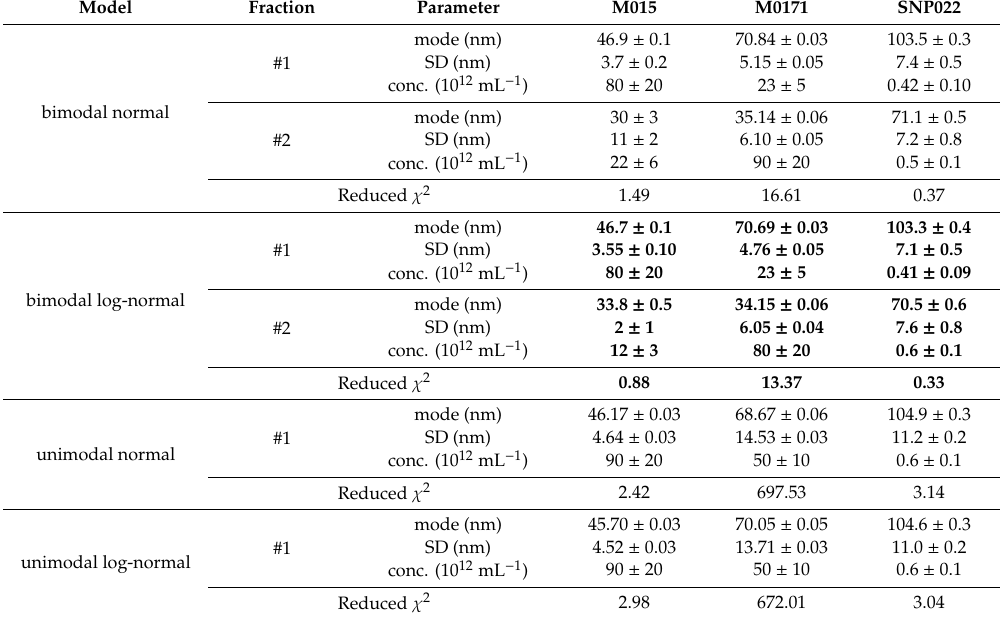
Table 2. Mode and scatter parameters as well as concentrations of the size fractions of the nanoparticle systems determined by SAXS assuming uni- and bimodal normal and log-normal size distributions. Values corresponding to the best fitting bimodal PSDs with log-normal size distributions are highlighted in bold typeface. Indicated standard error values were obtained from least-squares fitting